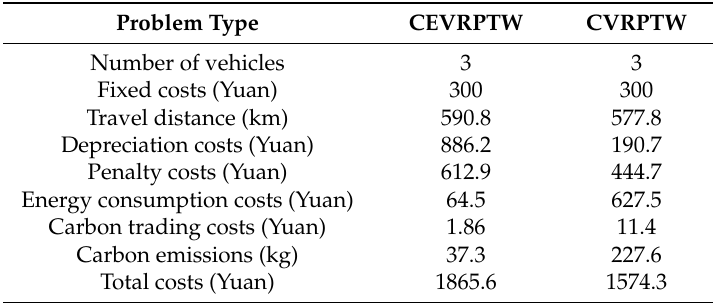
Table 7. Comparison of results for CEVRPTW and CVRPTW.